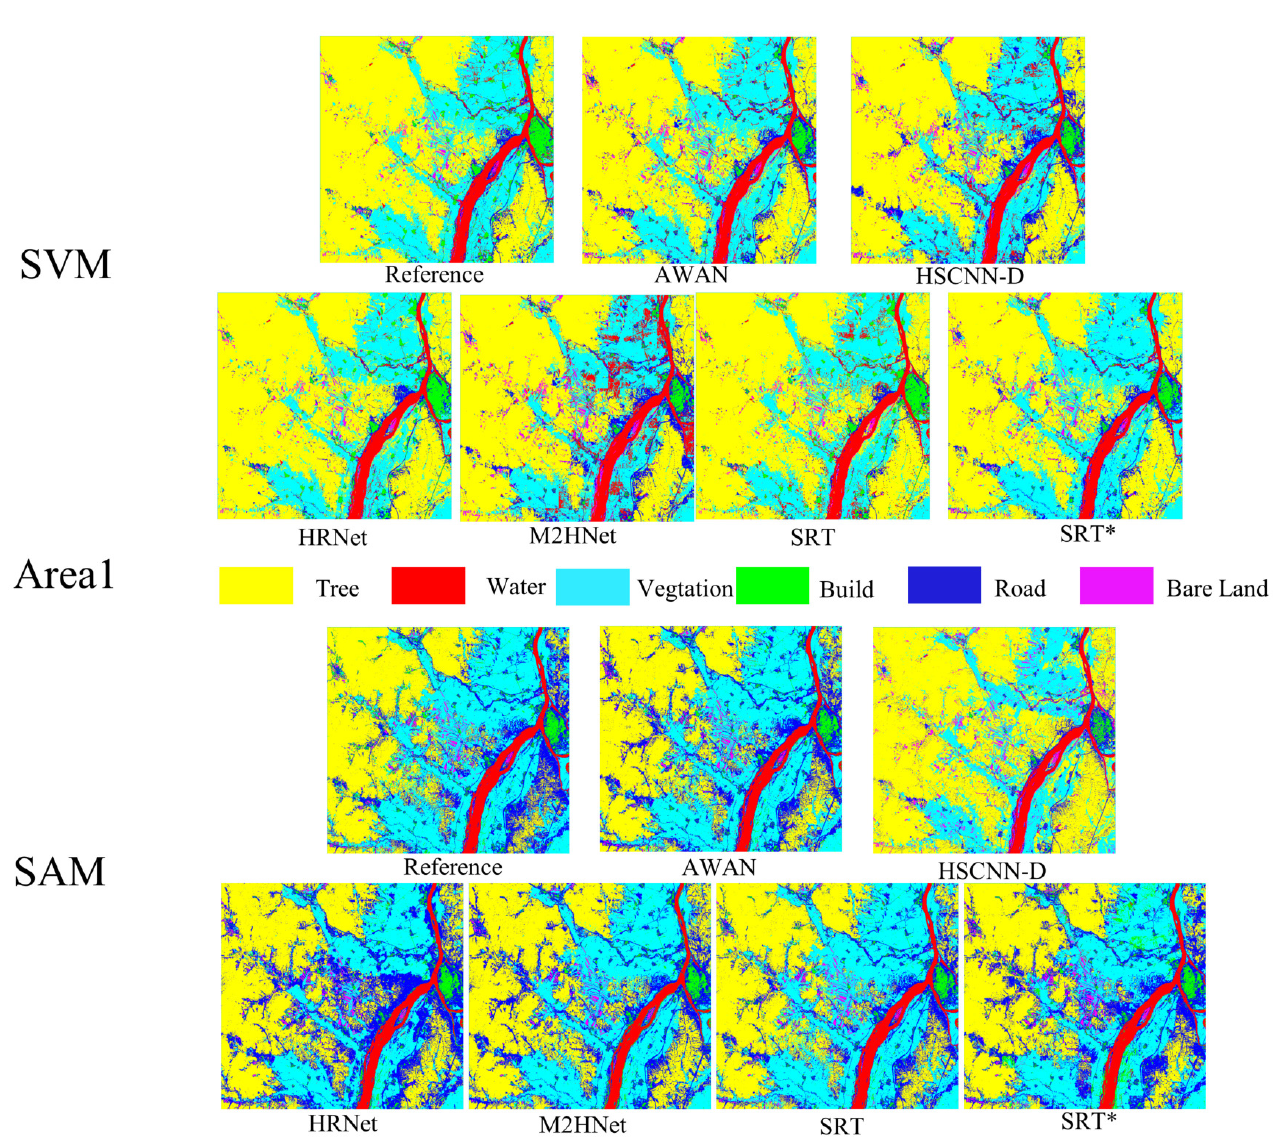
Figure 8. Result of SVM and SAM classification on Area1.